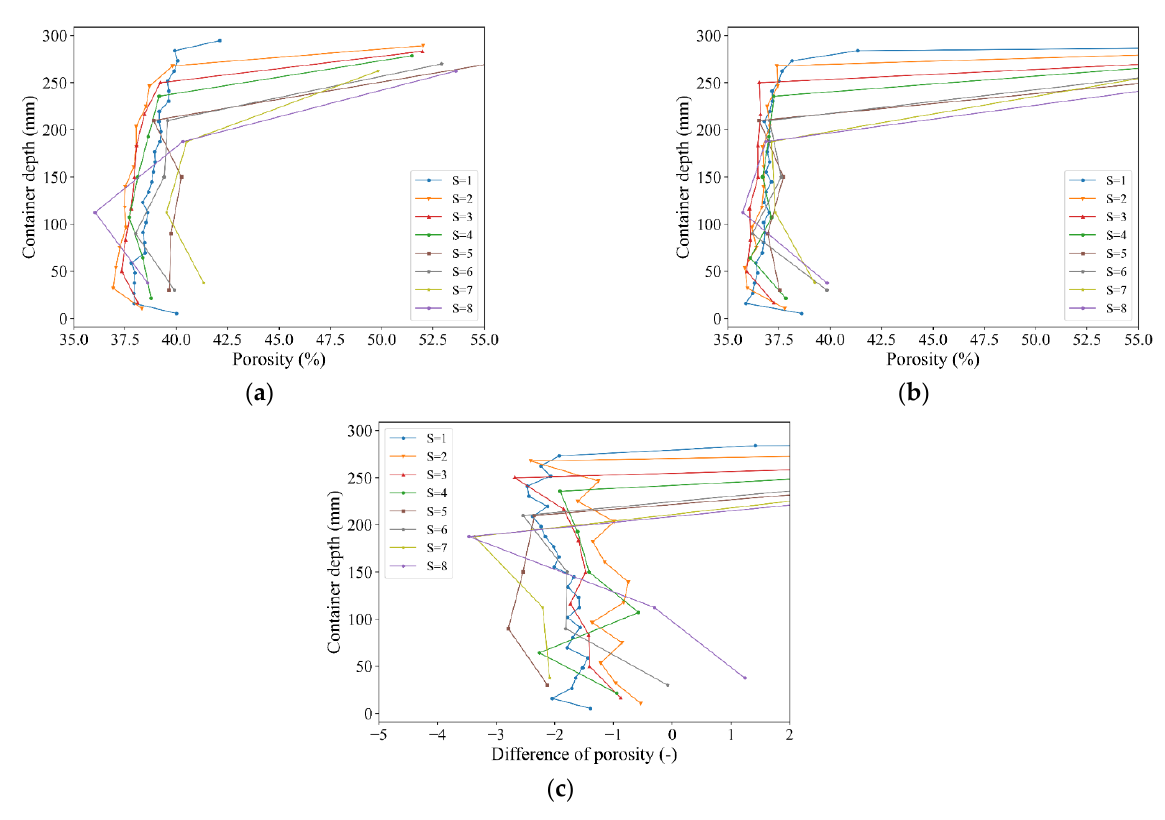
Figure 4. Coordination number distribution. ( a ) Before vibration; ( b ) After vibration; ( c ) Difference of coordination number after and before vibration.